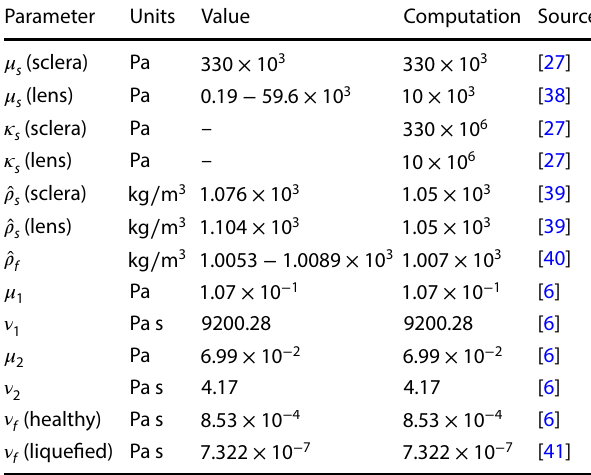
Table 4 Material parameters of the elastic structures (top) and parameters for the fluid domain (bottom) for human